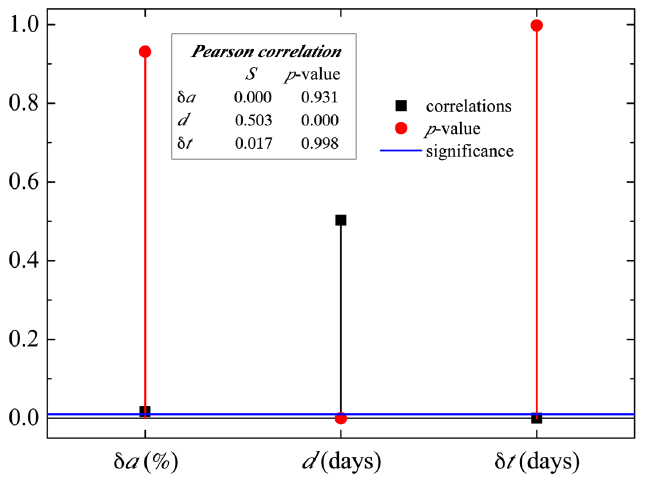
Figure 3. Results obtained for Pearson correlation tests for d a , d and d t with S